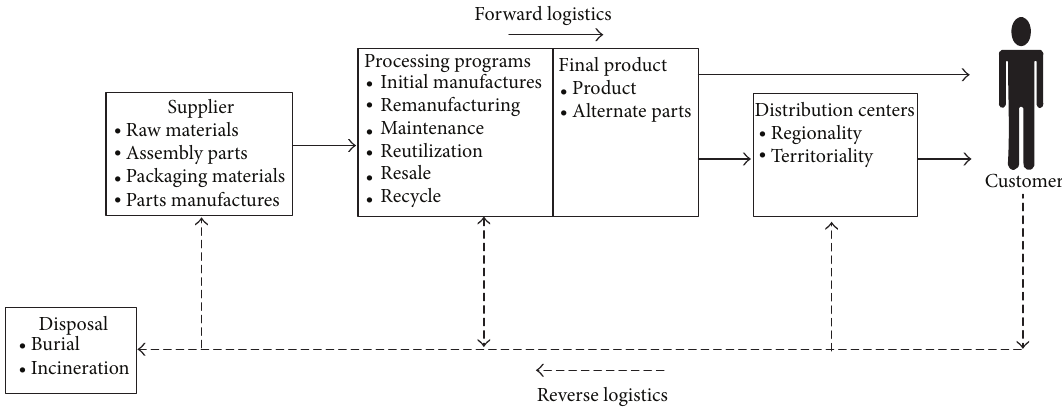
Figure 1: The reverse logistics flow of the products (Gattorna